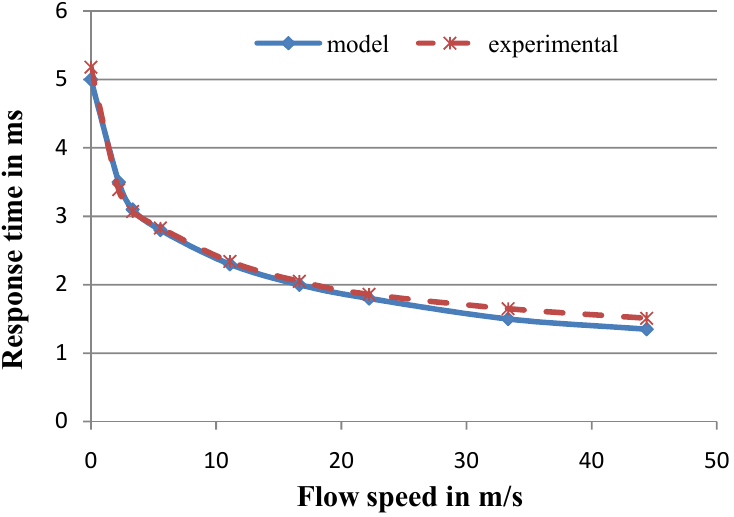
Figure 5. Comparison between experimental and model results for flow sensor (TS20) response time. Experimental results from measurements performed by Sosna et al. [3].